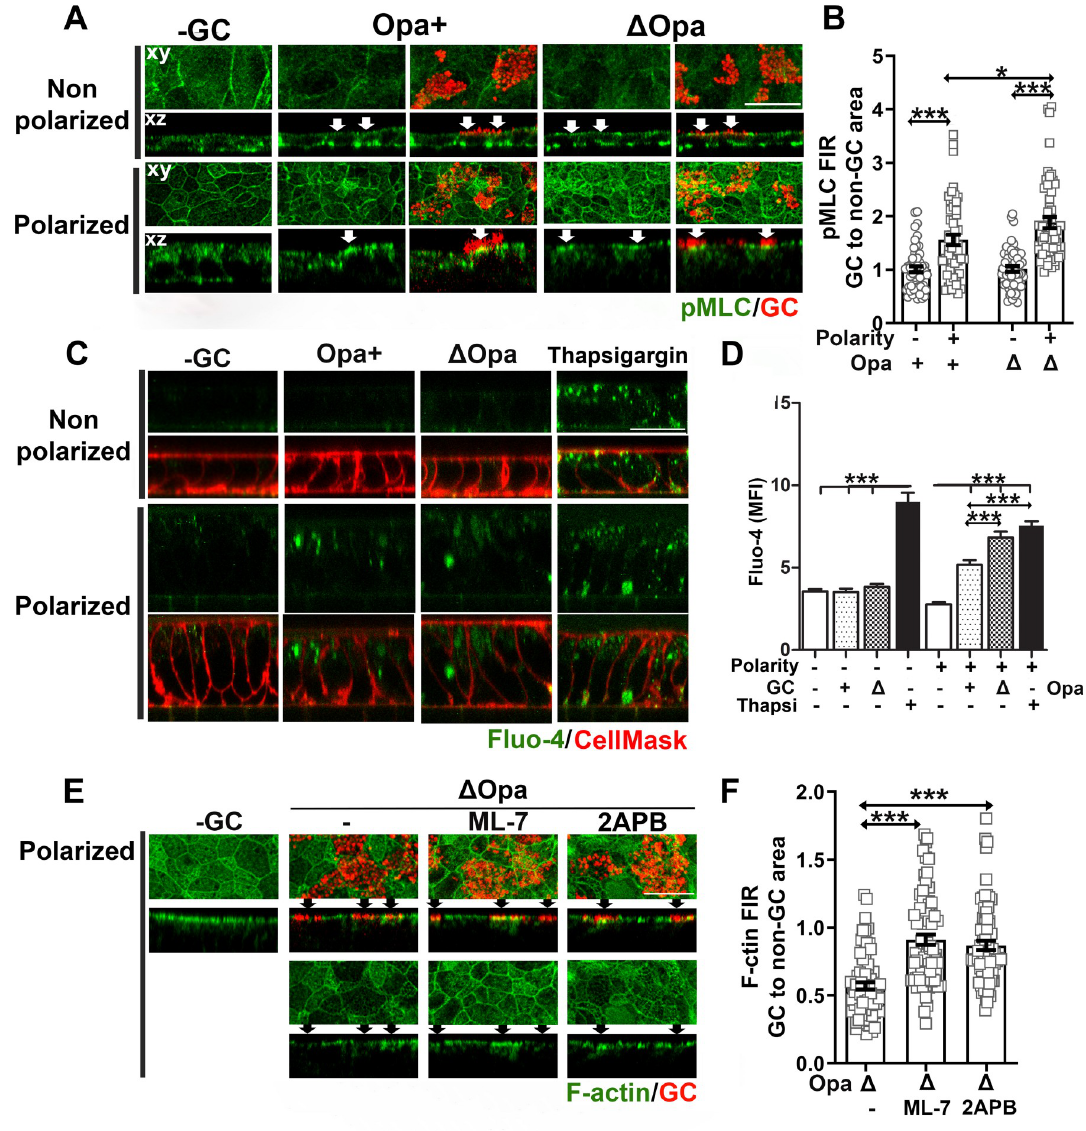
Fig 4. NMII activation and Ca 2+ elevation are required for GC-induced F-actin reduction at adherent sites of polarized epithelial cells. (A, B) Non-polarized and polarized T84 cells were inoculated with Pil+Opa+ or Δ Opa GC from the top chamber for 6 h (MOI~10). Cells were fixed and stained for phosphorylated myosin light chain (pMLC) and GC and analyzed using 3D-CFM. Shown are representative xy images of the top surface, xz images crossing both the top and the bottom surface (A), and the FIR ( ± SEM) of pMLC staining underneath individual GC microcolonies relative to the adjacent no GC surface area (B) . (C, D) Non-polarized and polarized T84 cells were incubated from the top chamber with or without GC Pil+Opa+ or Pil+ Δ Opa in the presence or absence of thapsigargin (10 μ M) for 4 h. Cells were incubated with the Ca 2+ indicator Fluo4 and the membrane dye CellMask and analyzed using 3D-CFM. Shown are representative xz images (C) and the mean fluorescence intensity (MFI) ( ± SEM) of Fluo-4 in the cytoplasmic region of individual epithelial cells (D) . (E, F) Polarized T84 cells were pre-treated with or without ML-7 (10 μ M) or 2APB (10 μ M) and apically inoculated with Pil+ Δ Opa GC in the presence or absence of inhibitors for 6 h (MOI~10). Cells were fixed and stained for F-actin using phalloidin and GC using antibody and analyzed using 3D-CFM. Shown are representative xy and xz images (E) and the FIR ( ± SEM) of phalloidin staining underneath individual GC microcolonies relative to the adjacent no GC surface area (F) . Data points in (B) and (F) represent individual GC microcolonies. Scale bar, 20 μ m. n = 3 three independent experiments. � p < 0.05; ��� p < 0.001.